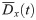
Estimates for cohort of individuals born between 1945 and 1964, for years 1999–2013, from model (12), (13) calibrated using data listed in S4 Table and S5 Table.Blue circles denote observed annual numbers of HCC and hepatitis C diagnoses for this cohort. A: Model estimates of total number of HCC diagnoses. B: Model estimates of total number of hepatitis C diagnoses. C: Model estimates of CHC prevalence rate Rx(t). D: Model estimates of proportion of CHC population undiagnosed D¯x(t).